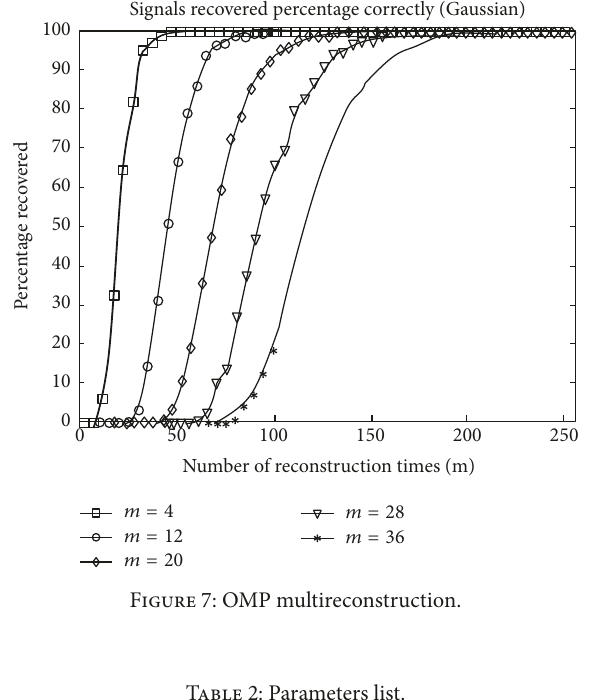
Table 2: Parameters list.